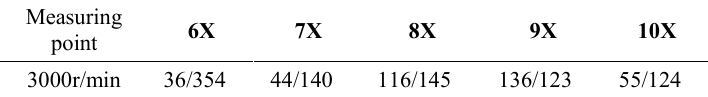
Table 2. Vibration data at 450MW (before dynamic balancing).